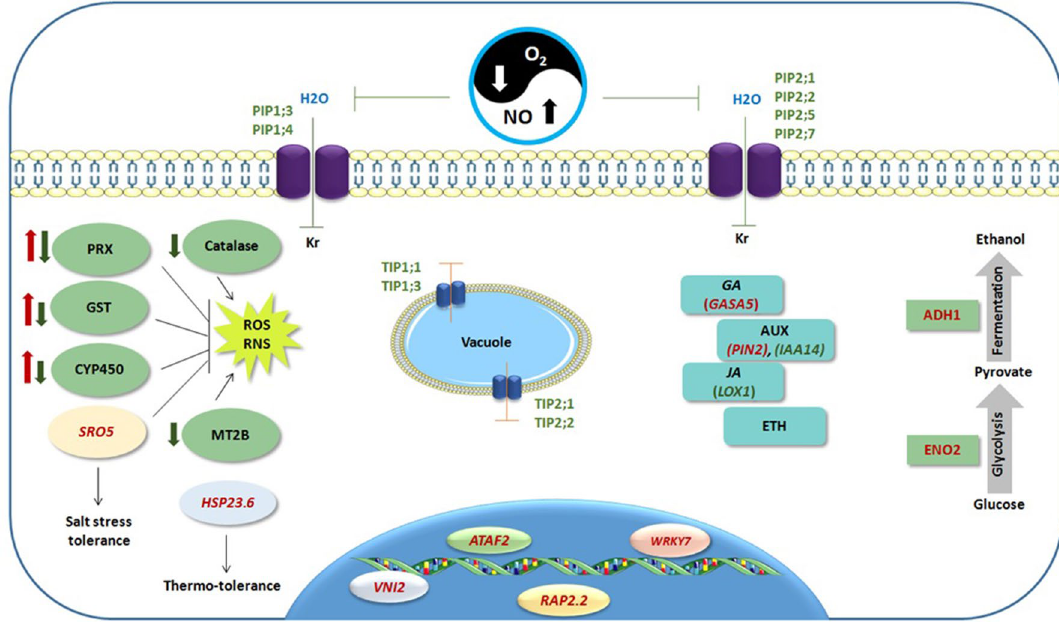
Figure 13. A schematic model of the molecular response of tomato root to the yin and yang of oxygen and nitric oxide. Depicted are the genes belonging to different biological categories with identified or proposed roles in response to hypoxia and/or NO. Red and green font colors or arrows represent up- and down-regulation, respectively. ADH1 , ALCOHOL DEHYDROGENASE 1 ; ENO2 , ENOLASE 2 ; CA1 , CARBONIC